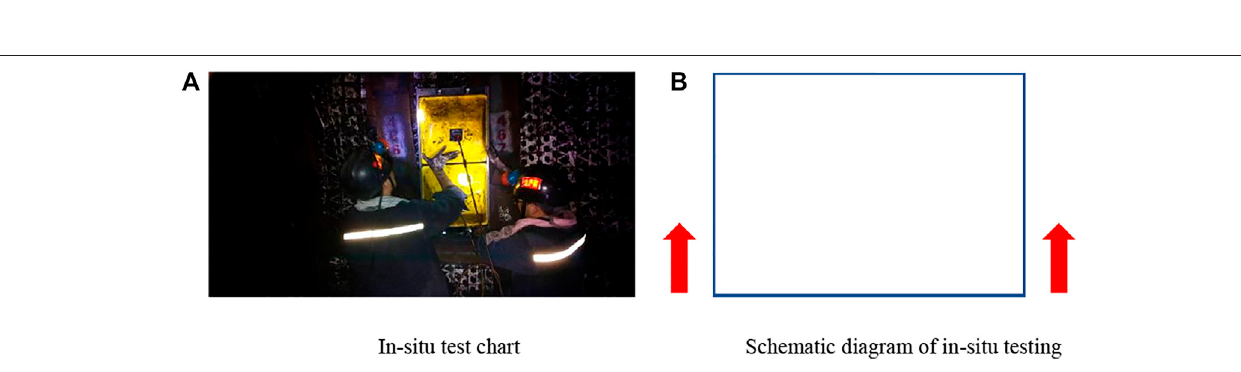
Frontiers in Earth Science |